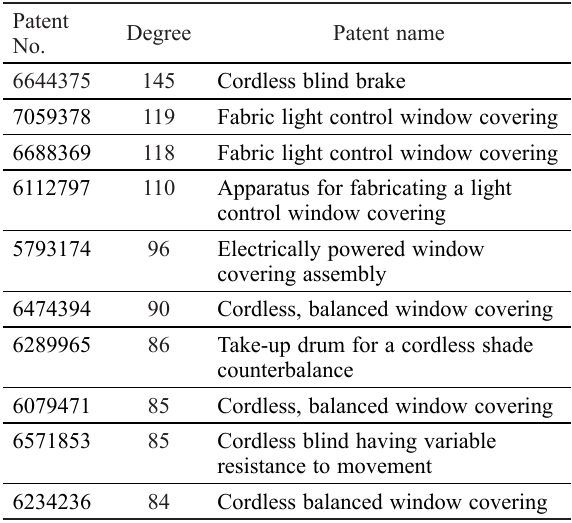
Table 4. Degree centrality of the top 10 patents in the technology field Patent No.